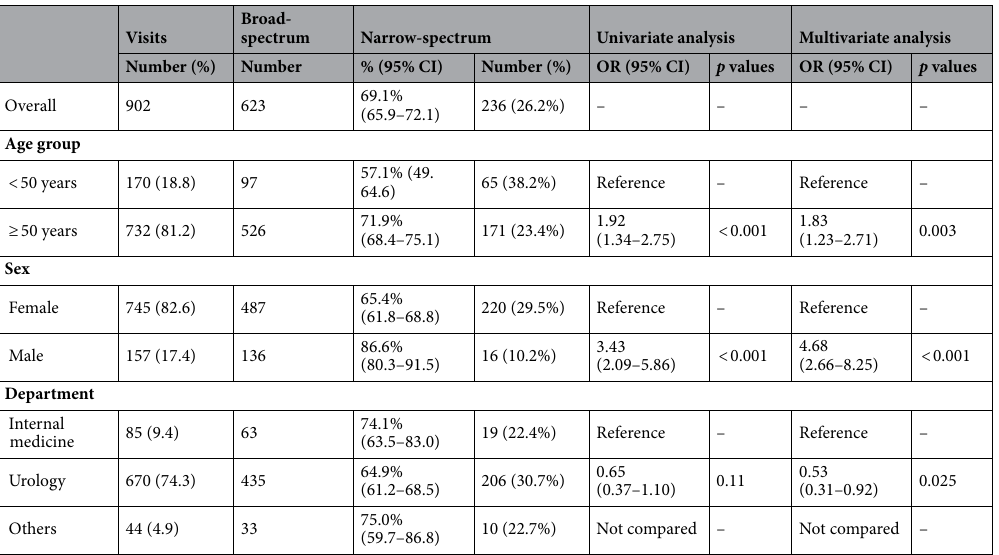
Table 4. Univariate and multivariate analysis for broad-spectrum antimicrobial prescriptions for uncomplicated cystitis. CI confidence interval, OR odds ratio. Total number of 902 cases were subjected to the univariate analysis (Chi-square test) and multivariate analysis (logistic regression model).